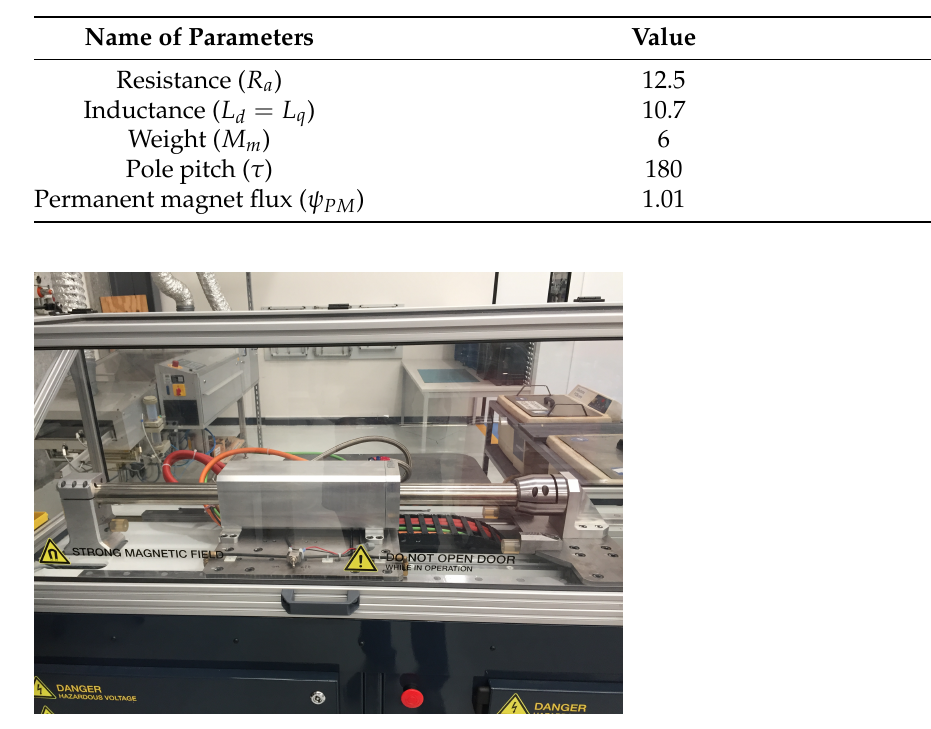
Figure 3. Linear permanent magnet synchronous tubular motor used for system identification.